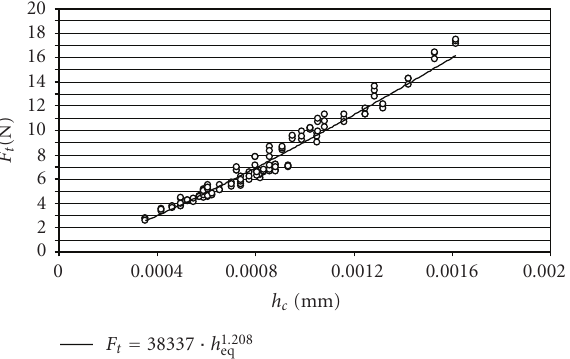
Figure 7: Comparison of model and experimental data of F t .